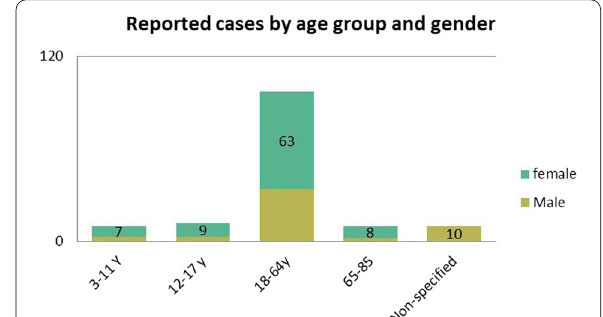
Fig. 1 Reported cases of adverse events associated with sanitizers use by age group and gender